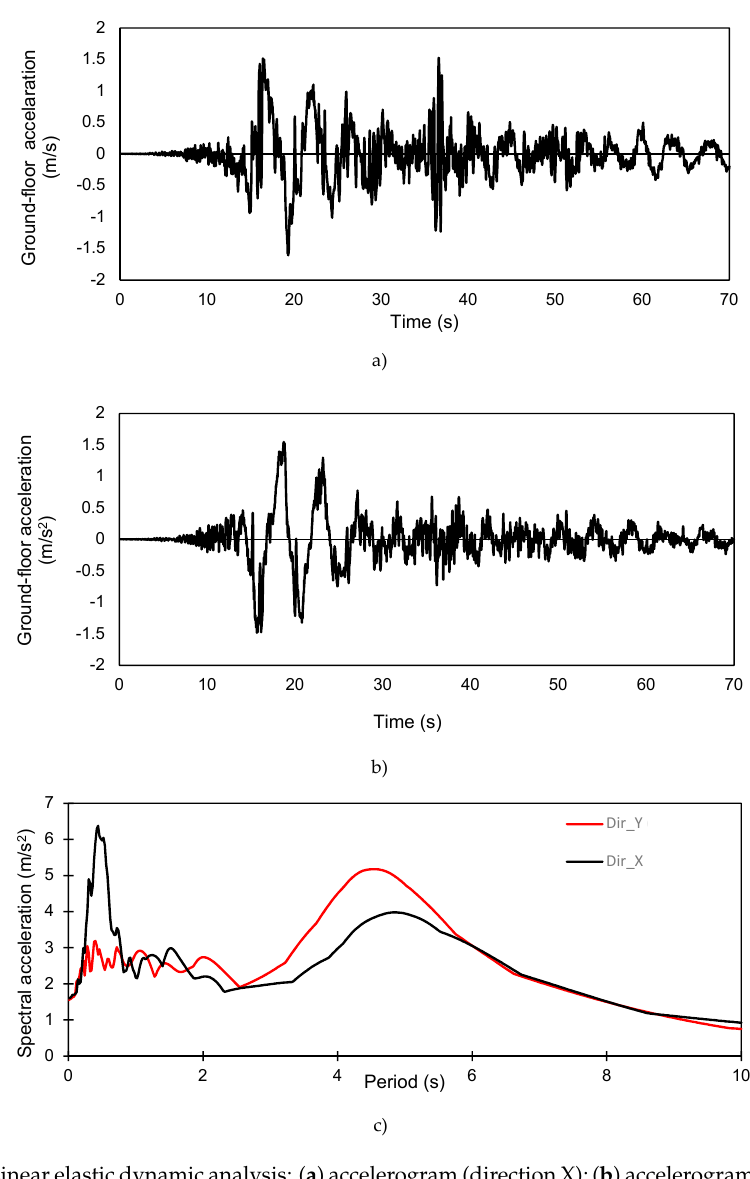
Figure 13. Linear elastic dynamic analysis: ( a ) accelerogram (direction X); ( b ) accelerogram (direction Y); and ( c ) spectral acceleration.